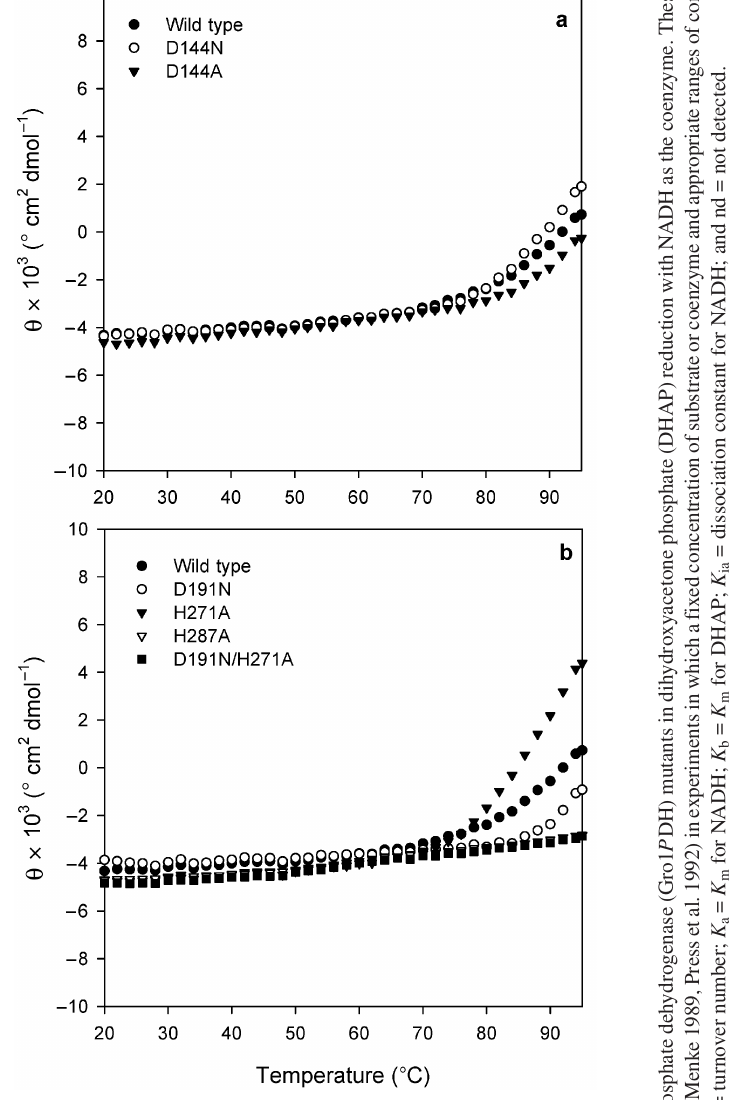
Figure 2. Thermal unfolding curves for the wild type and mutant sn -glycerol-1-phosphate dehydrogenase (Gro1 P DH) (0.21–0.34 mg ml –1 ) at 222 nm of CD. Abbreviation: θ =